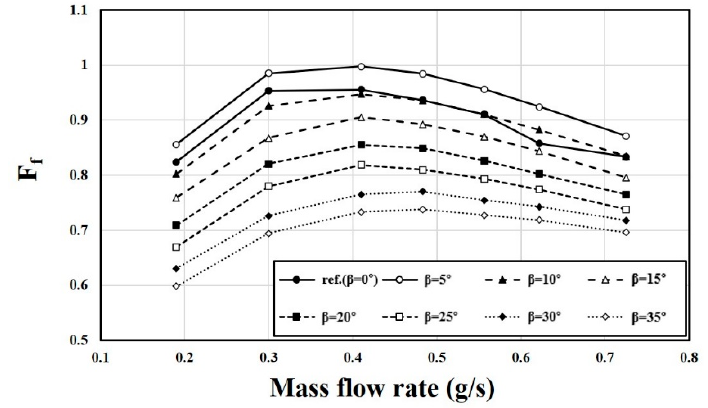
Figure 11. Variations of dimensionless pressure drop with mass flow rate for various bending angles.